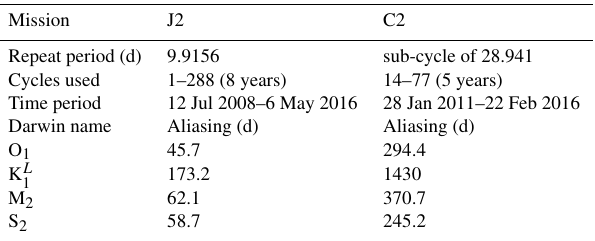
Table 3. Description of the altimeter database for the validation study, along with the associated aliasing periods for the main tidal